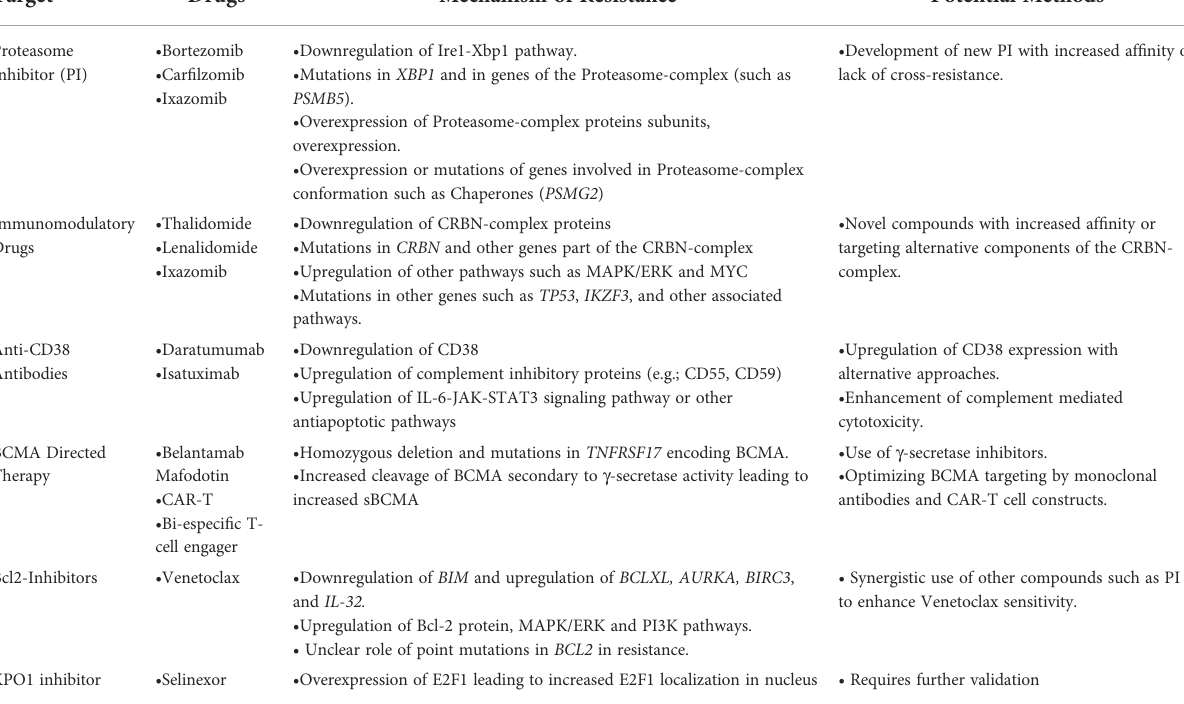
TABLE 1 Proposed mechanism of resistance and